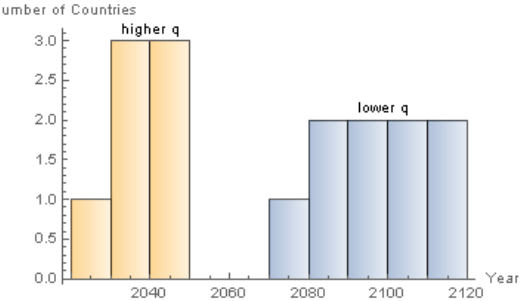
Figure 4. Histogram of years of 95% market adaptation by ZEBs (country with R 2 > 0.9 included) [own study].